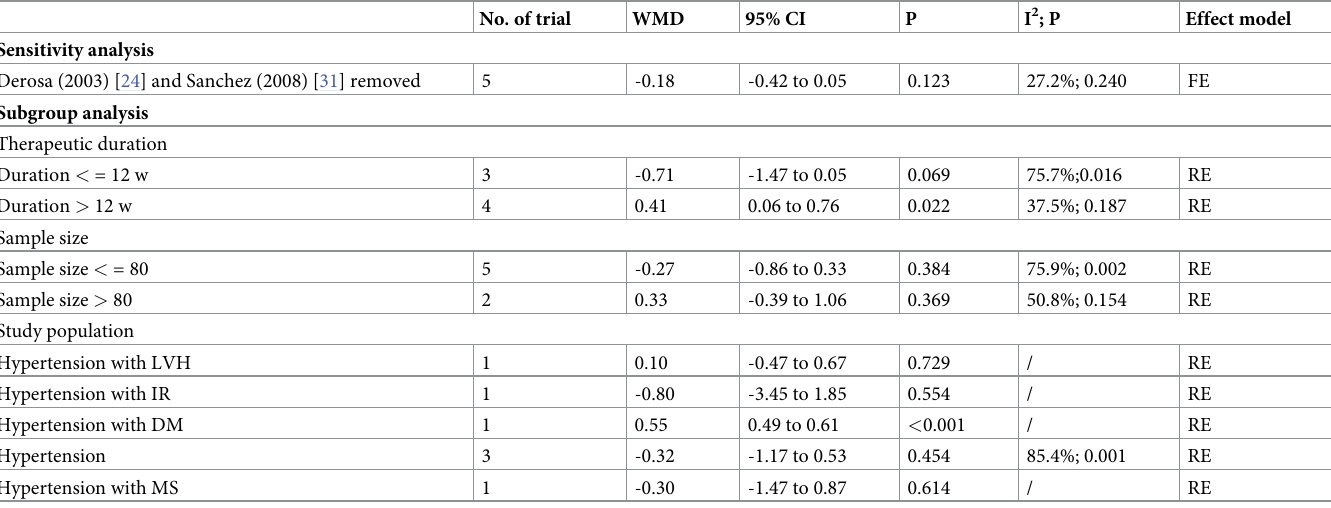
Table 4. Sensitivity analysis and subgroup